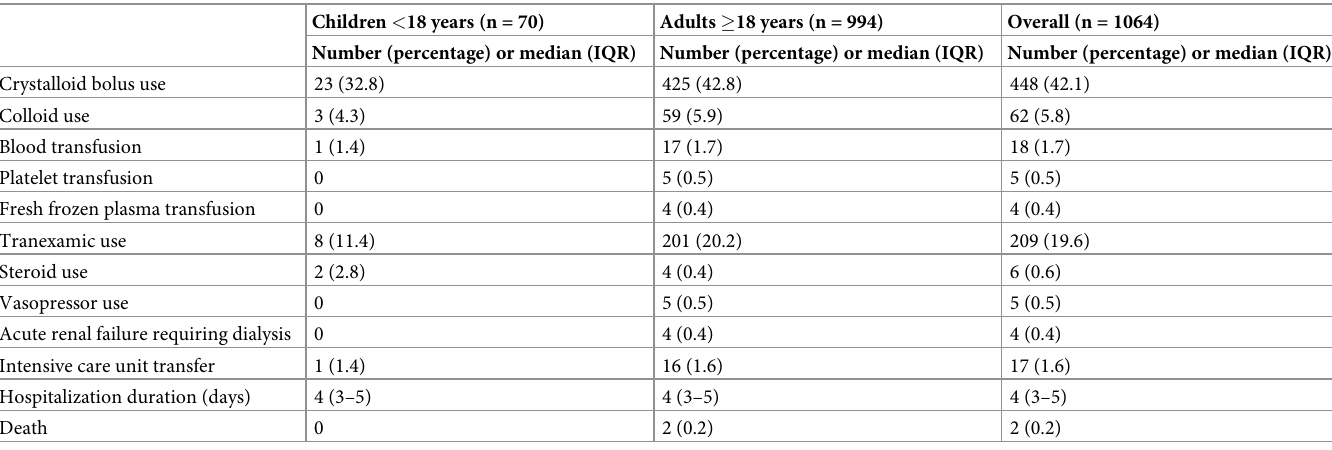
Table 5. Secondary outcomes during hospitalization among children and adults with acute dengue in Southern Province, Sri Lanka, 2017–2018. Children < 18 years (n =